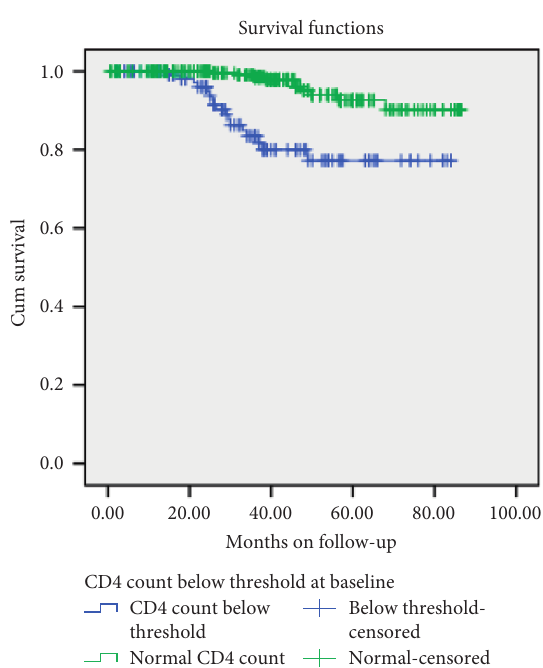
Figure 3: Survival curves for the cohort of children on ART according to their CD4 count.